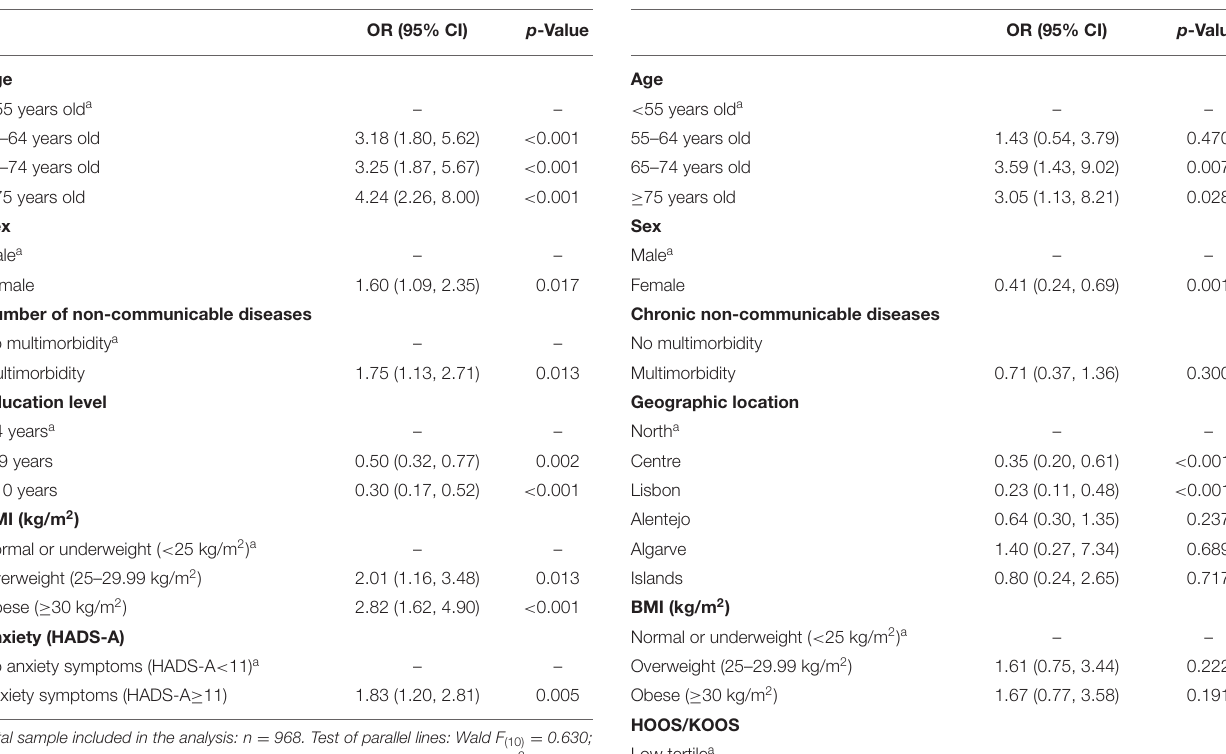
TABLE 5 | Factors associated with radiographic severity in the final multivariable ordinal regression